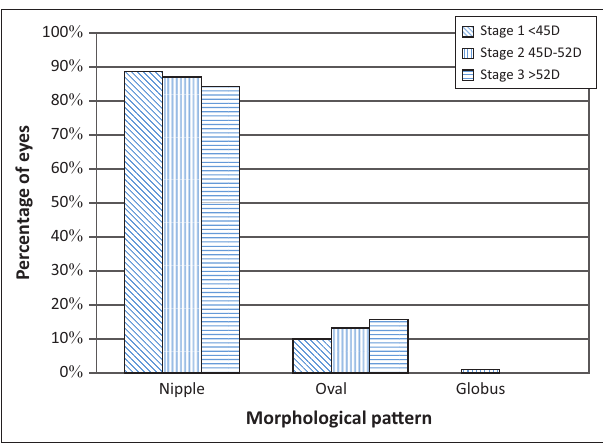
FIGURE 3: The frequency distribution of cone morphological patterns for the Stage of keratoconus.